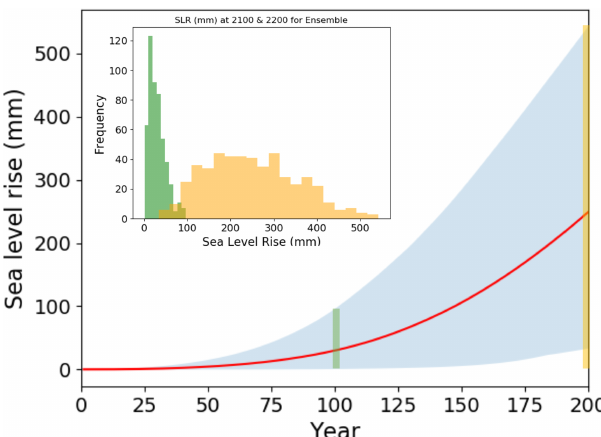
Figure 9. The 500-member ensemble SLR contributions (mm) from year 0 to 200: distribution (blue shading) and ensemble mean (red curve). Inset shows sea level rise histogram (mm) at year 100 (green) and 200 (orange) of simulations, corresponding to the ver- tical green and orange lines in the main panel. Note the tighter dis- tributions at year 100 than at year